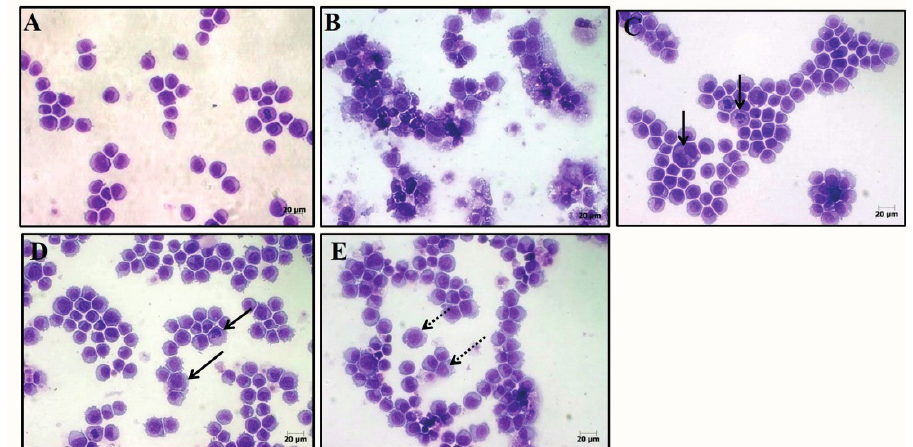
Figure 4. Effect of 16 on cell morphology for HL-60 human leukemia cells. The cells were stained with hematoxylin-eosin and analyzed by optical microscopy after 24 h incubation at concentrations of 0.32 ( C ); 0.64 ( D ); and 1.28 μ g/mL ( E ). Negative control ( A ) was treated with the vehicle (0.1% DMSO) used for diluting the test substance. Doxorubicin (0.3 μ g/mL) was used as the positive control ( B ). Continuous arrows show nuclear fragmentation and non-continuous arrows show accumulation of metaphases